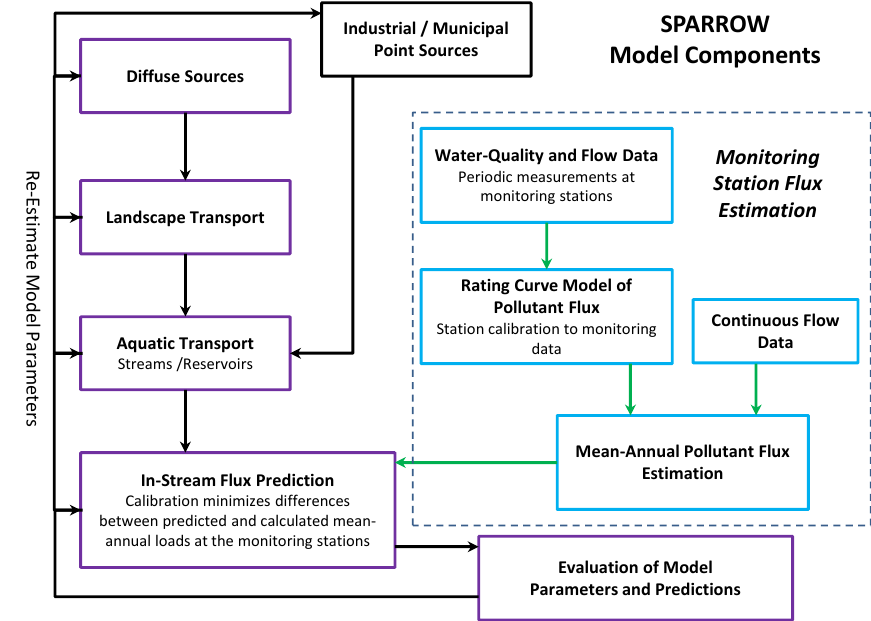
Figure 2. Schematic of the major SPARROW model components (from Schwarz et al.,